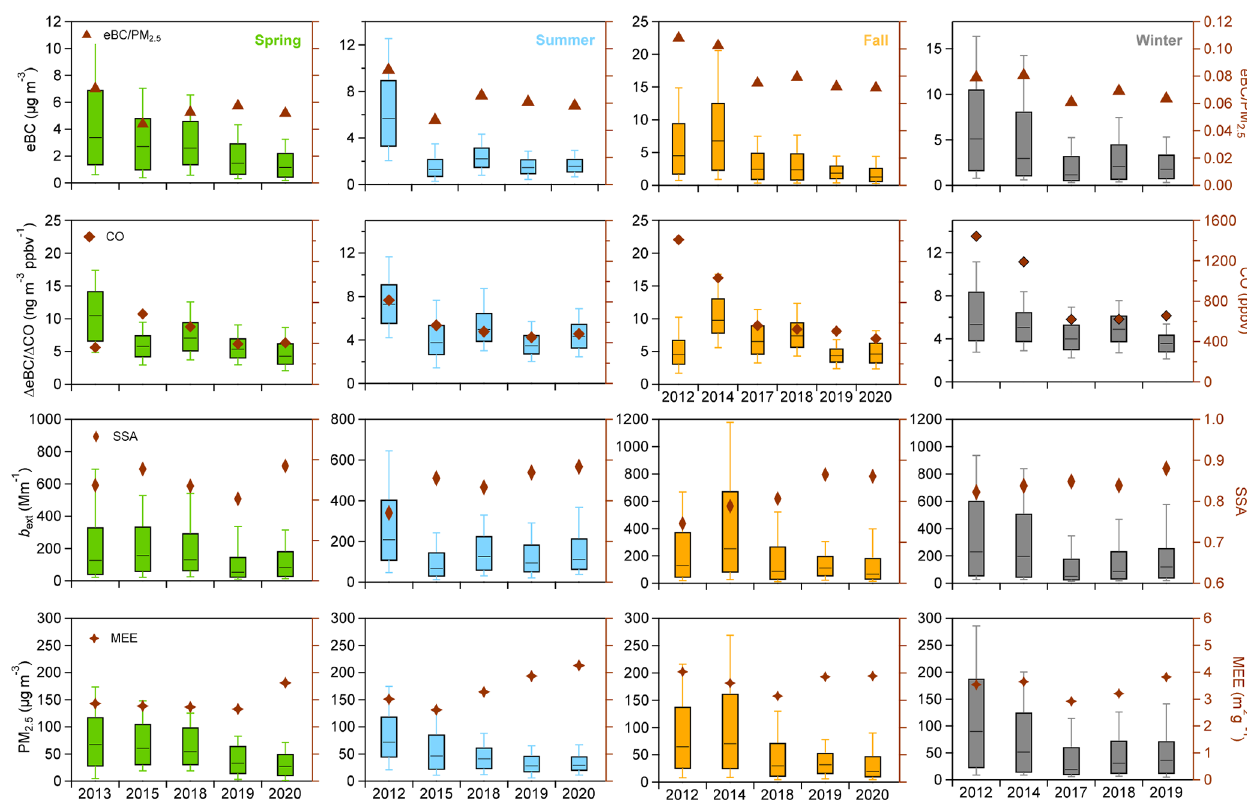
Figure 3. Seasonal variations in eBC, eBC / PM 2 . 5 , (cid:49) eBC /(cid:49) CO, CO, b ext , SSA, PM 2 . 5 , and MEE.